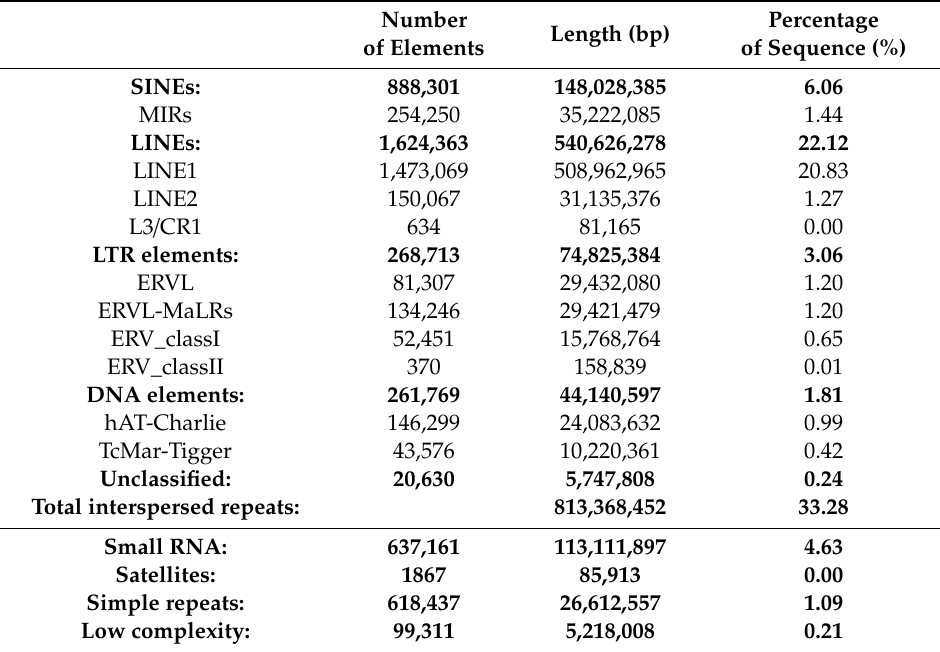
Table 3. Statistics for annotated Mirounga leonina transposable elements.